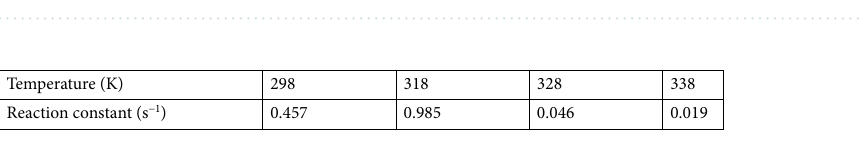
Figure 12. Influence of the reaction temperature on the hydrogen production rate using the proposed composite (15% Mo precursor) calcined at 850 °C at 0.05 V/s scan rate.